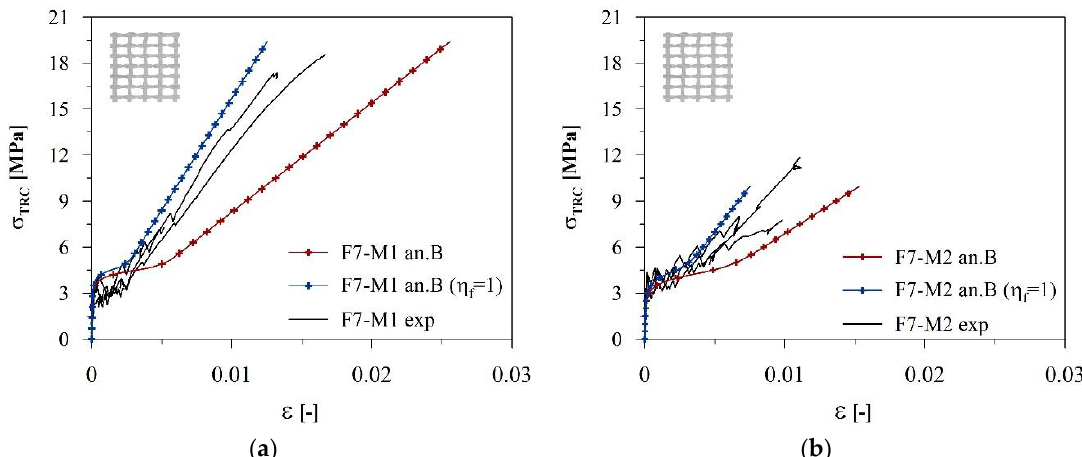
Figure 23. Effect of fabric efficiency on the predicted analytical response and comparison with the experimental data in terms of nominal stress vs. strain for M1-based ( a ) and M2-based ( b ) composites reinforced with F7 fabric.